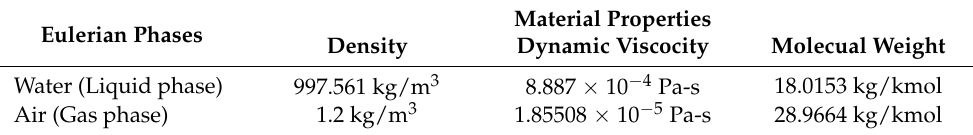
Table 1. Liquid and gas phases representing a two-phase fluid flow in the hydrocyclone.